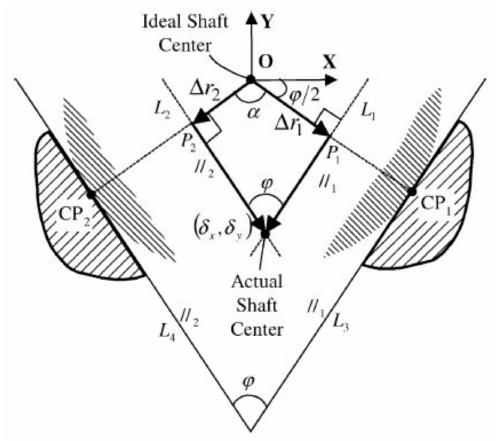
Figure 56. Geometry to define the position of the spindle’s centre in the plane of contact